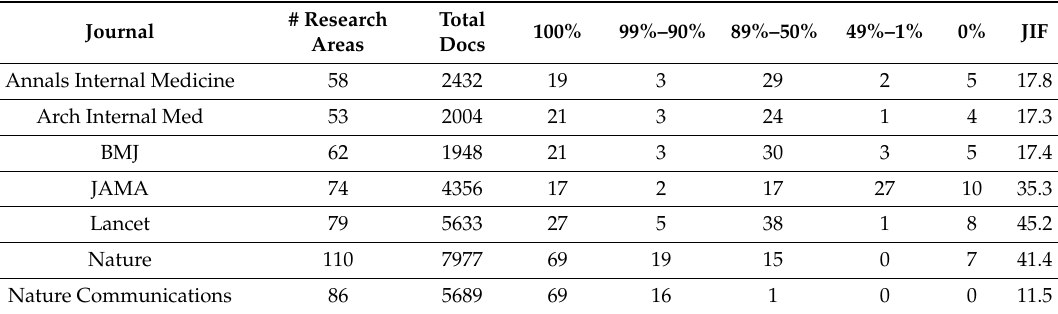
Table 3. Distribution of document citations by research areas in Multidisciplinary